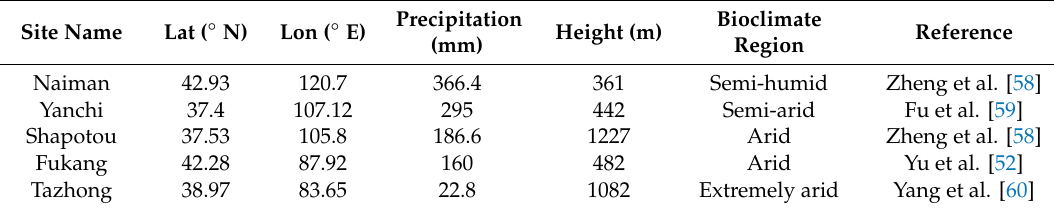
Table 1. Information on the five flux sites in the sandy areas of northern China